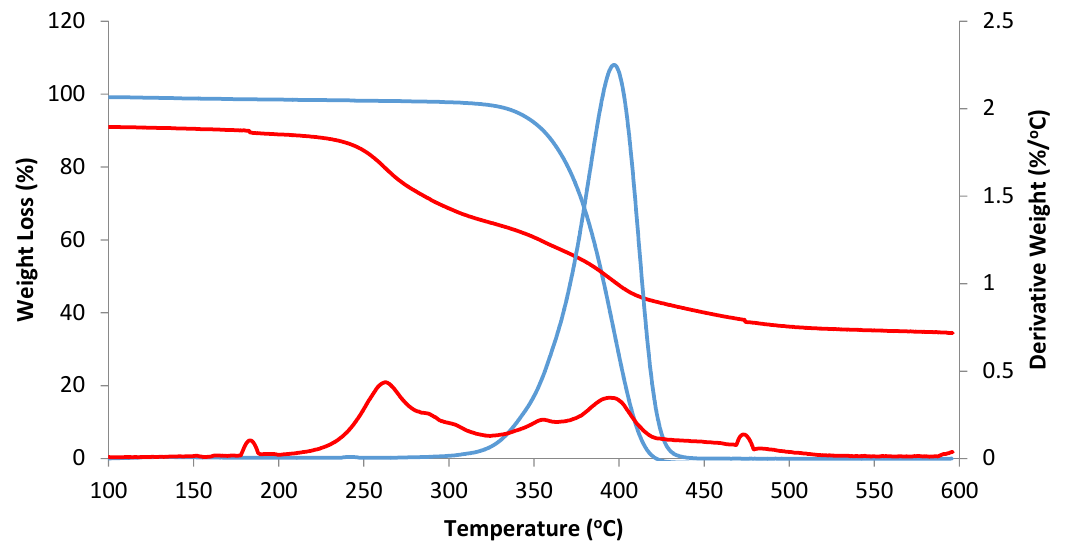
Figure 6. Thermogravimetric analysis (TGA) of PPEGMA (blue line) and CTS ‐ g ‐ GMA ‐ PPEGMA (red line).